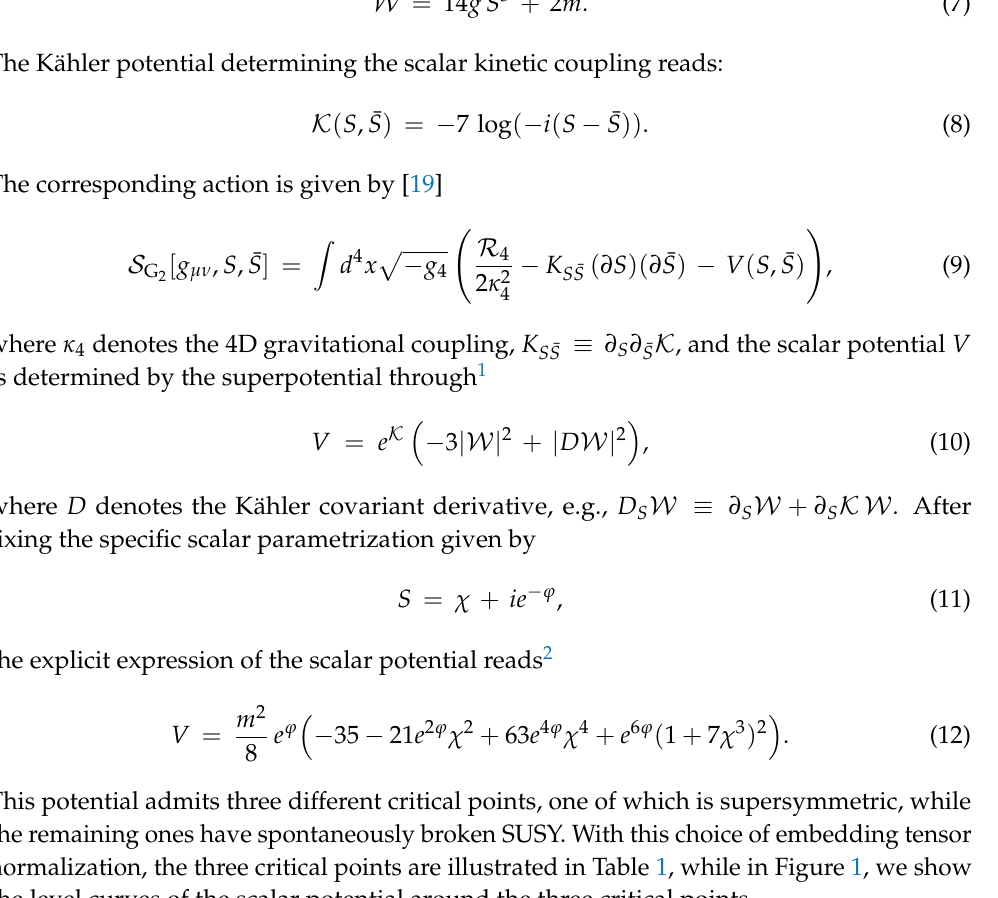
Table 1. The three different AdS critical points of ISO ( 7 ) gauged supergravity preserving at least G 2 as residual symmetry. The squared masses of the G 2 singlet modes are normalized to the absolute value of the cosmological constant. In these units, the BF bound [20] lies at m 2 ID SUSY G